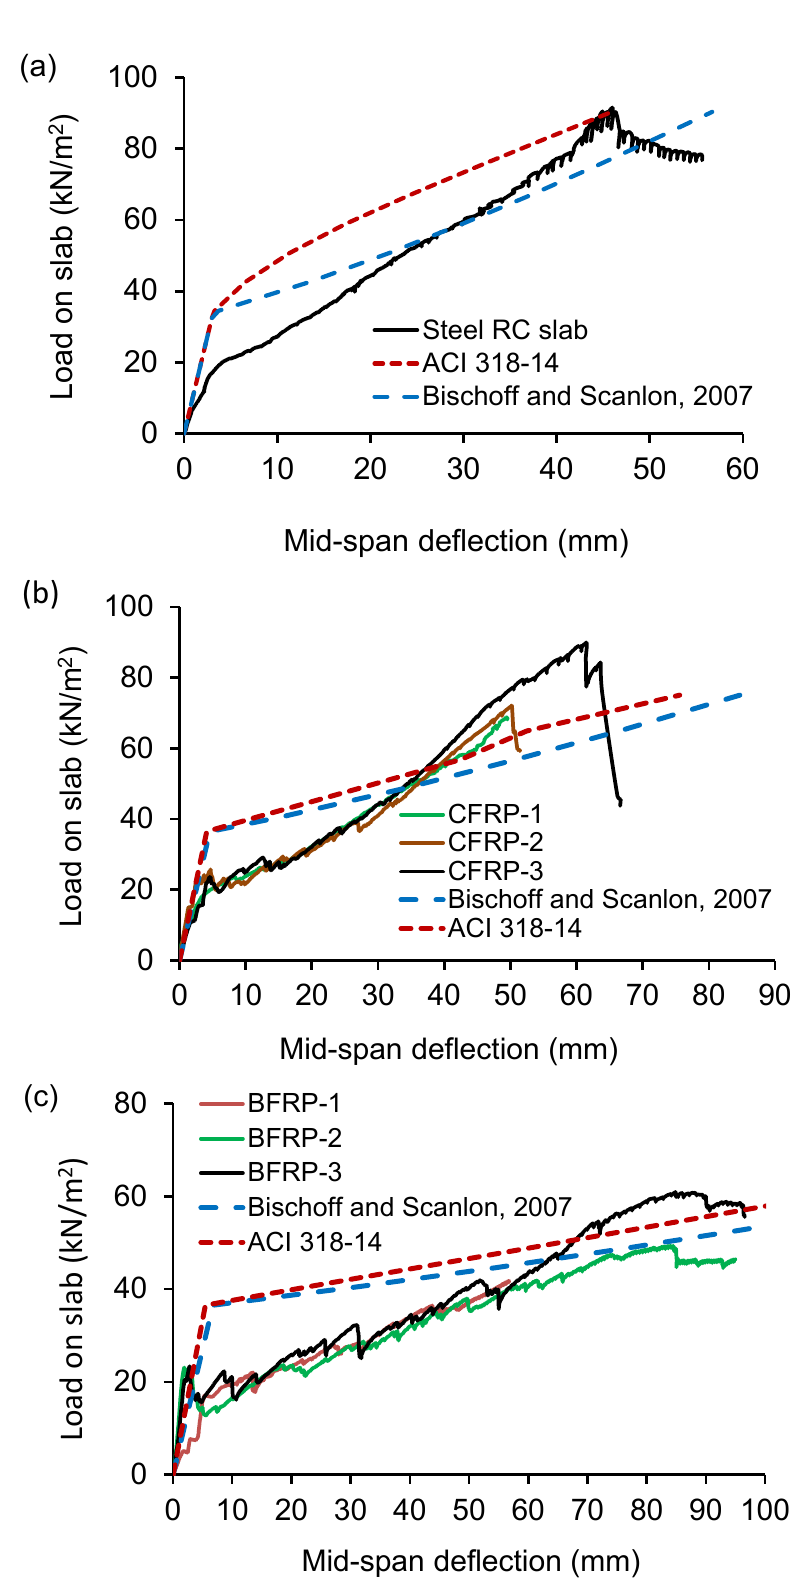
Figure 9. Theoretical and experimental load–deflection curves of ( a ) steel, ( b ) CFRP, and ( c ) BFRP- RC slabs.